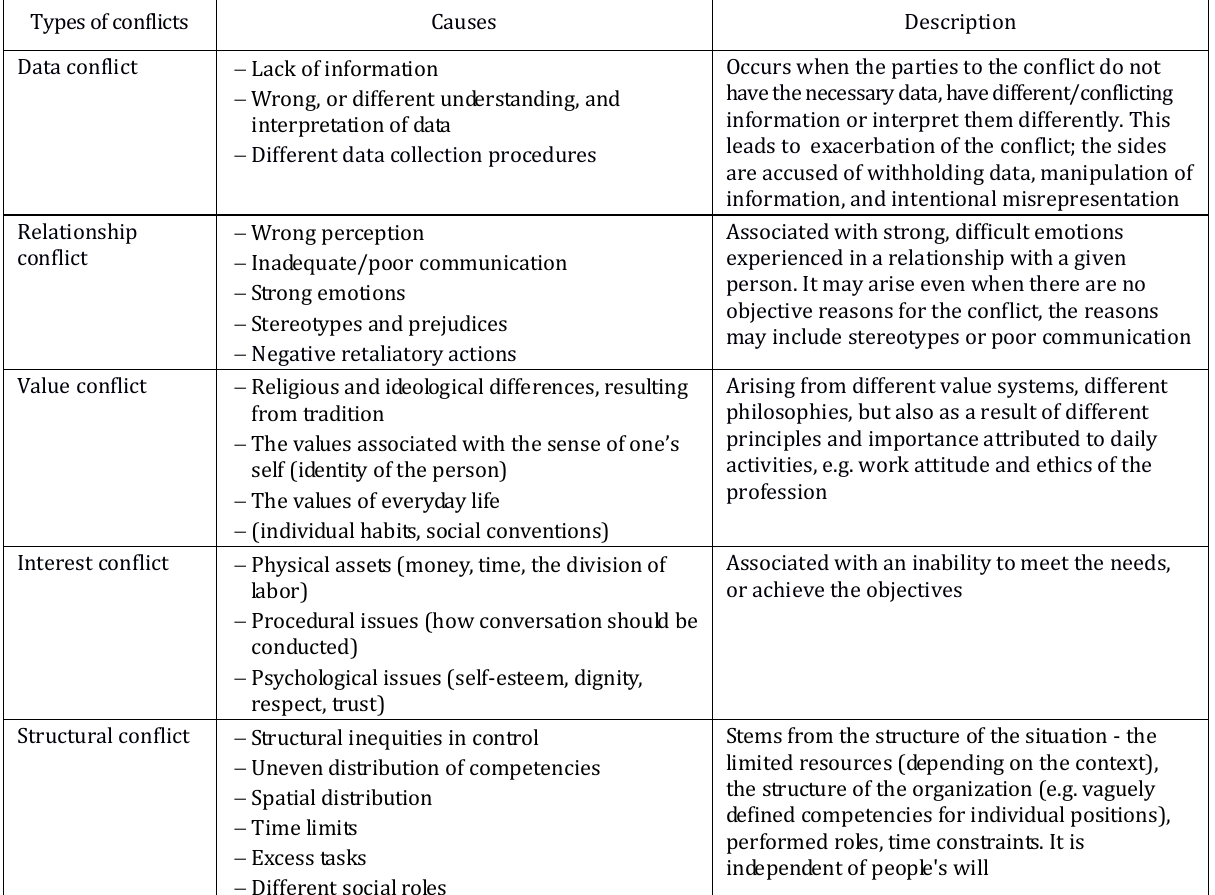
Table 2. Types of conflicts according to Ch.W. Moore (2009), own work (JIB) based on Ch. W. Moore